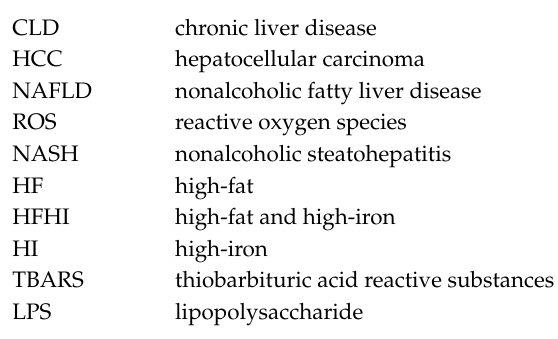
Figure S1: Temporal changes of biochemical and liver weight data, Table S1: Necropsy and biochemical data. Acknowledgments: This work was supported by JSPS KAKENHI (No. 17K08084 and 26850184). Author Contributions: M.A. and T.I. conceived and designed the experiments; M.A., R.M., S.O. and A.H. performed the experiments; M.A., T.I., M.K. and J.Y. analyzed the data; M.A. and T.I. wrote the